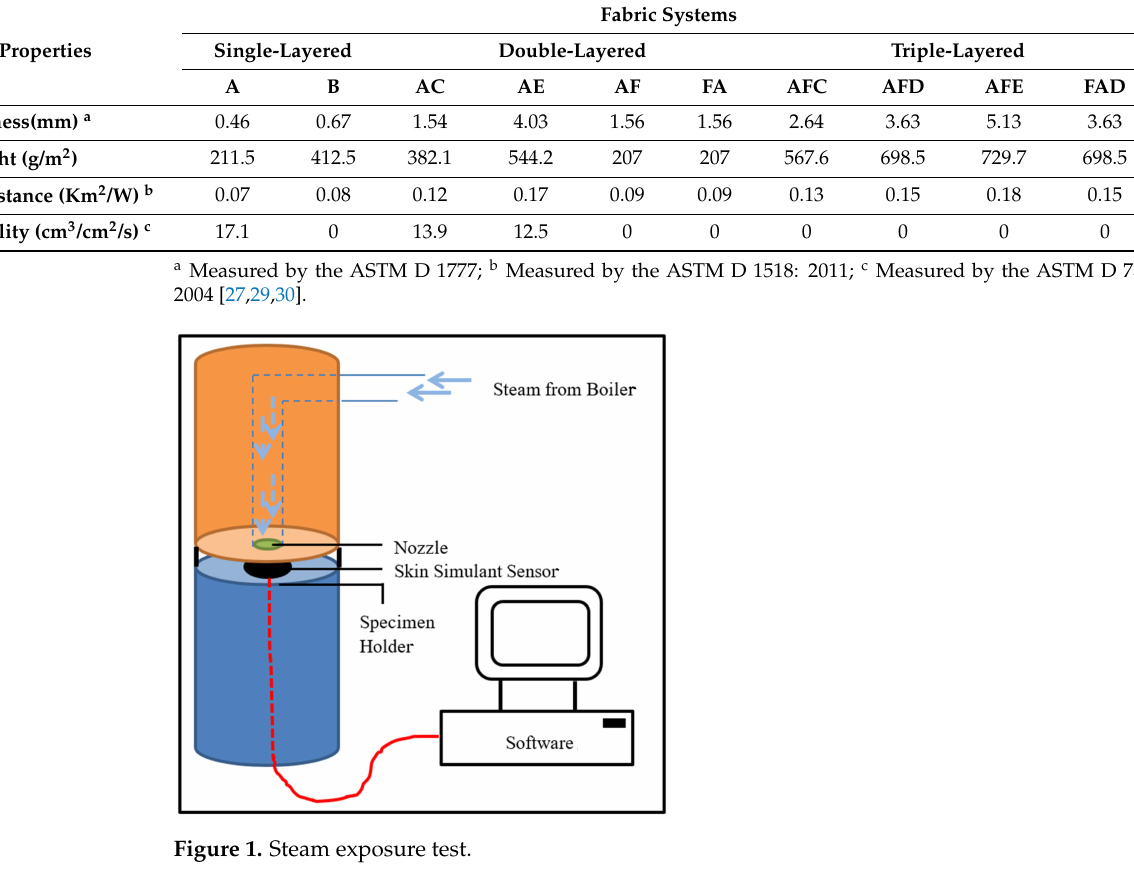
Table 2. Assembled fabric systems.